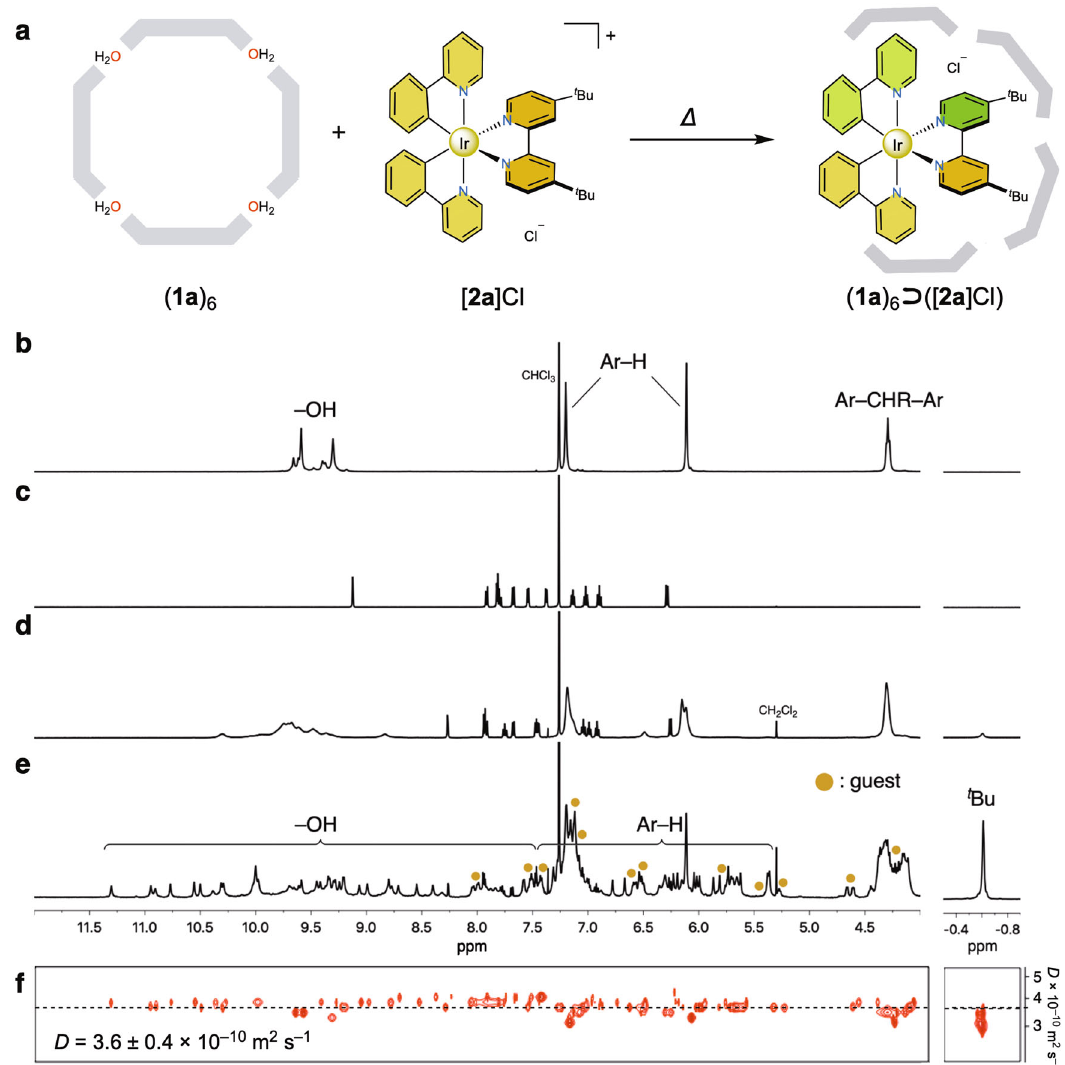
Fig. 2 | Symmetry-breaking assembly consisting of resorcin[4]arene and cationic Ir complex. a Schematic representation of the assembly. 1 H NMR spectra (500MHz, CDCl 3 , RT) of b resorcin[4]arene hexameric capsule ( 1a ) 6 , c Ir complex [ 2a ]Cl, d a mixture of ( 1a ) 6 and [ 2a ]Cl, e the mixture after heating at 50°C for 1h,